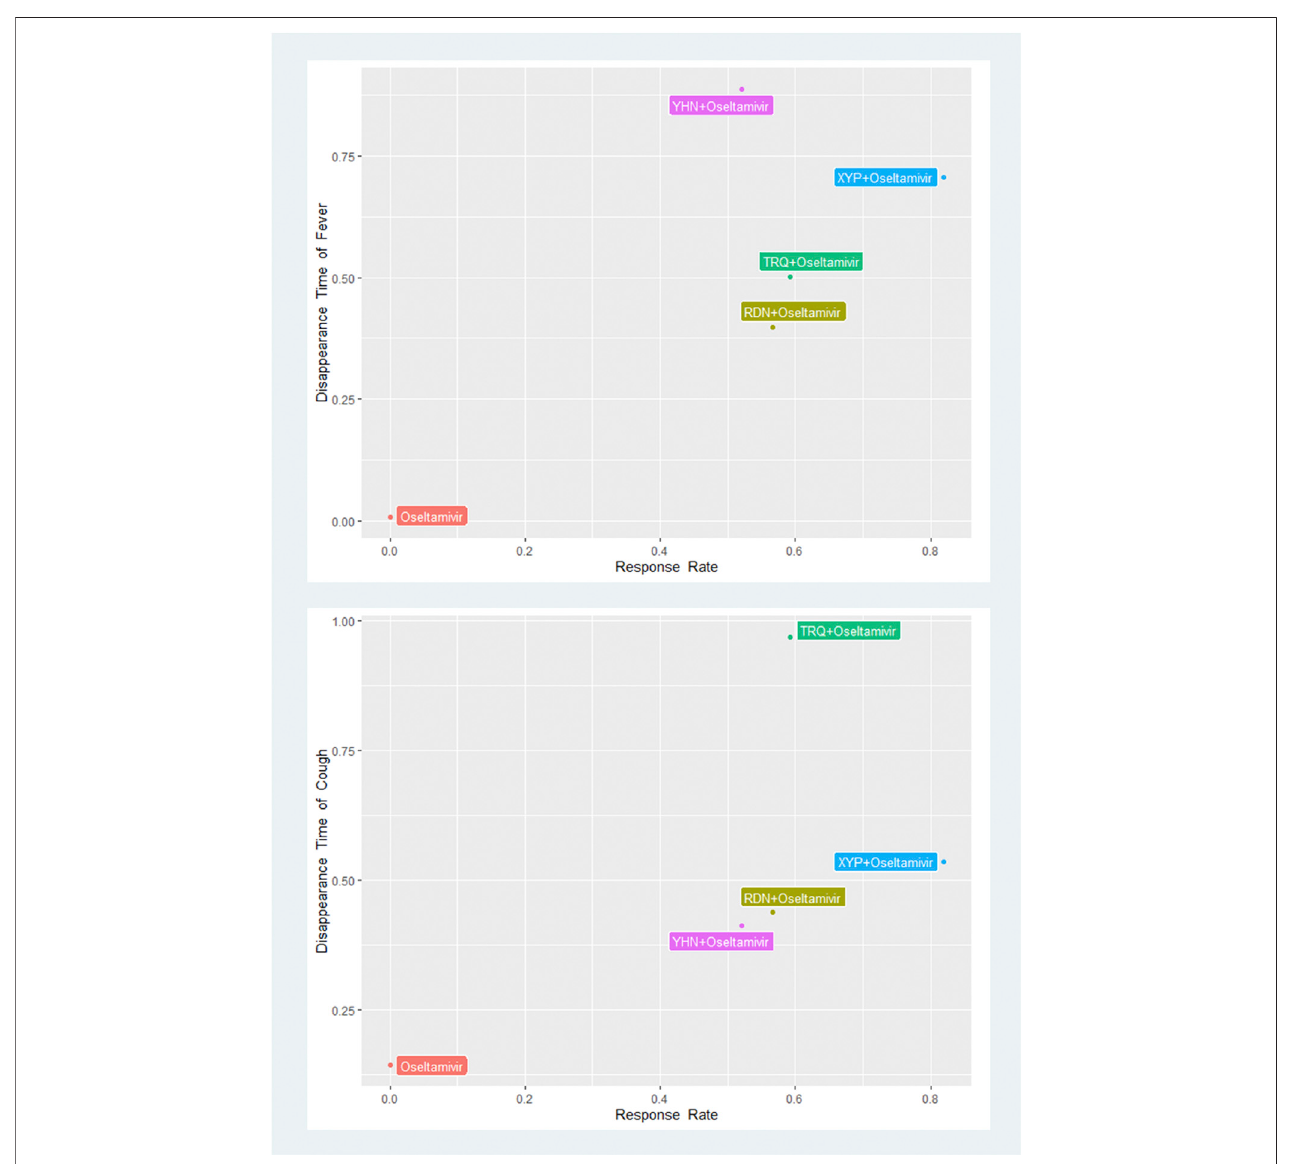
FIGURE 4 | SUCRA biplots of primary outcomes. XYP, Xiyanping; RDN, Reduning; TRQ, Tanreqing; YHN, Yanhuning. SUCRA, the surface under the curve cumulative ranking.